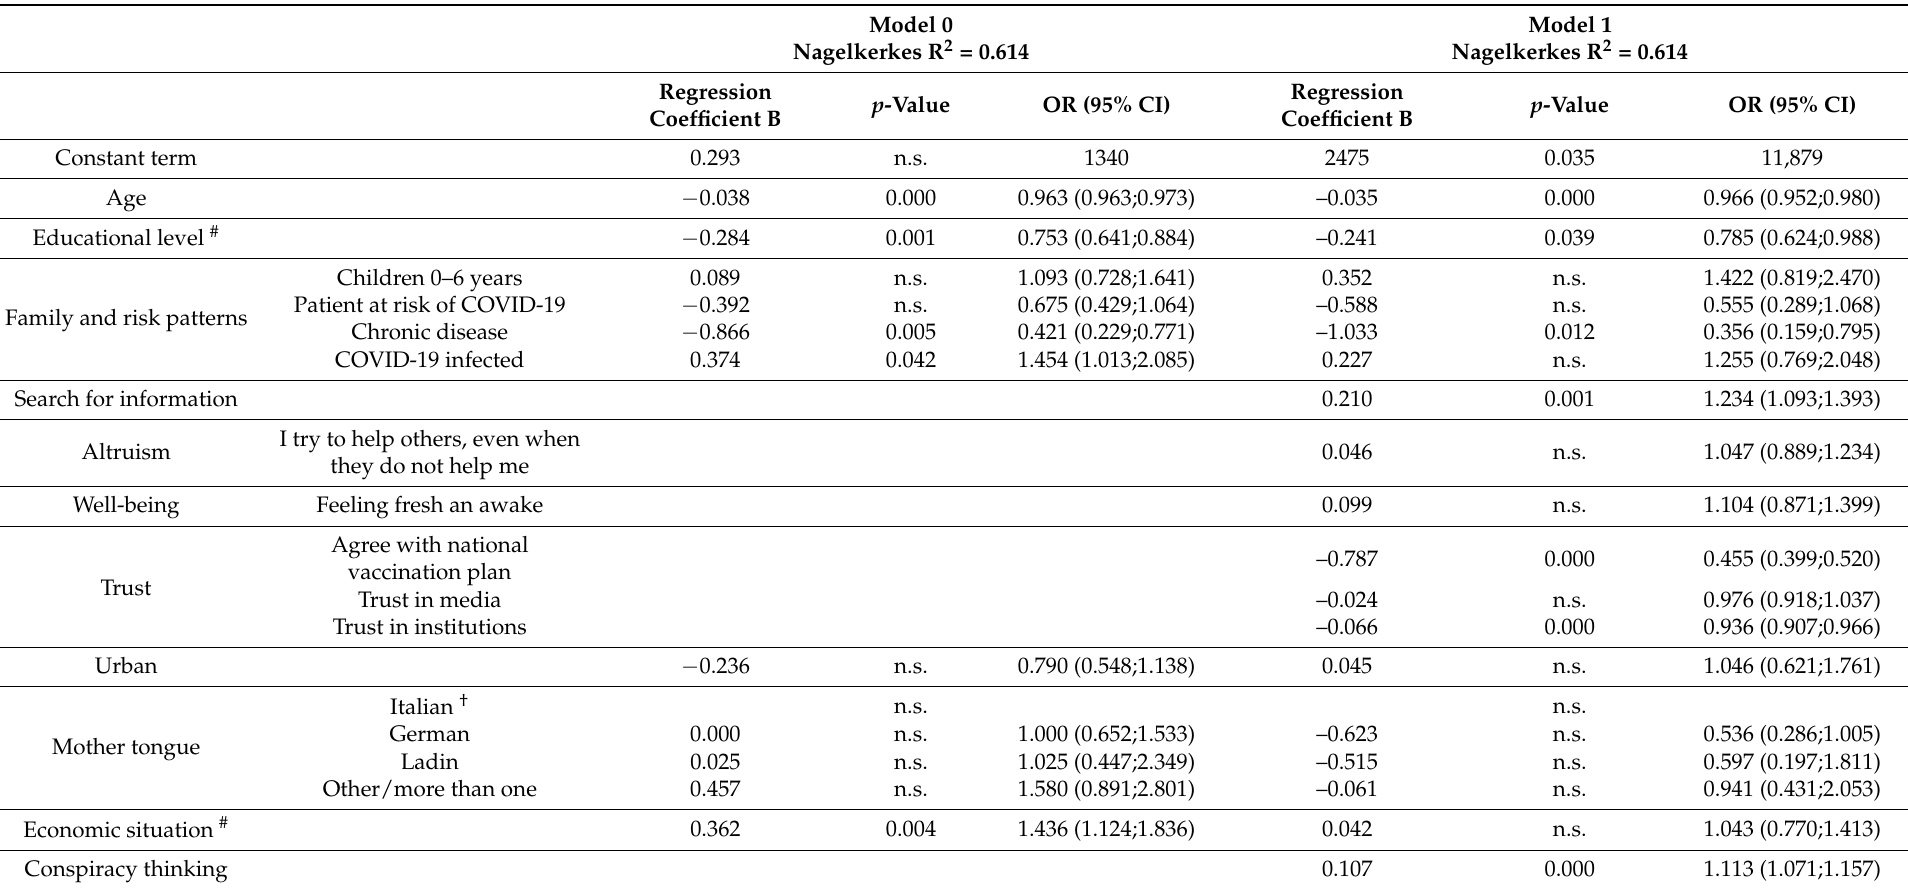
Table 5. Predictors of vaccination hesitancy in South Tyrol, Italy, in March 2021 in multivariate logistic regression